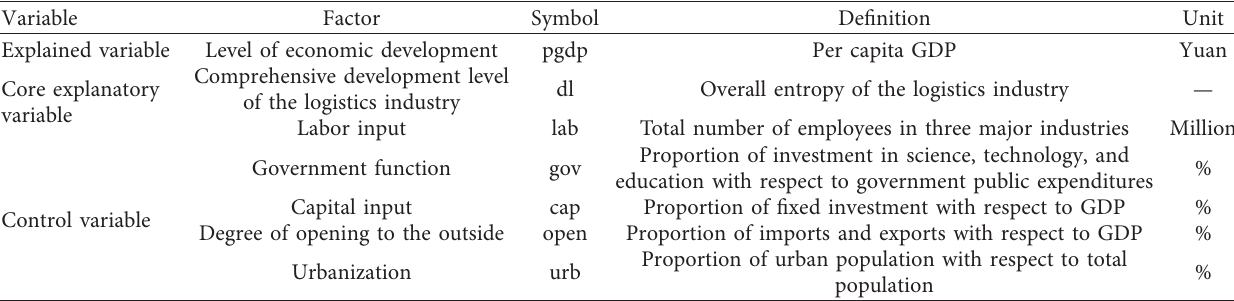
Table 2: Variable description.